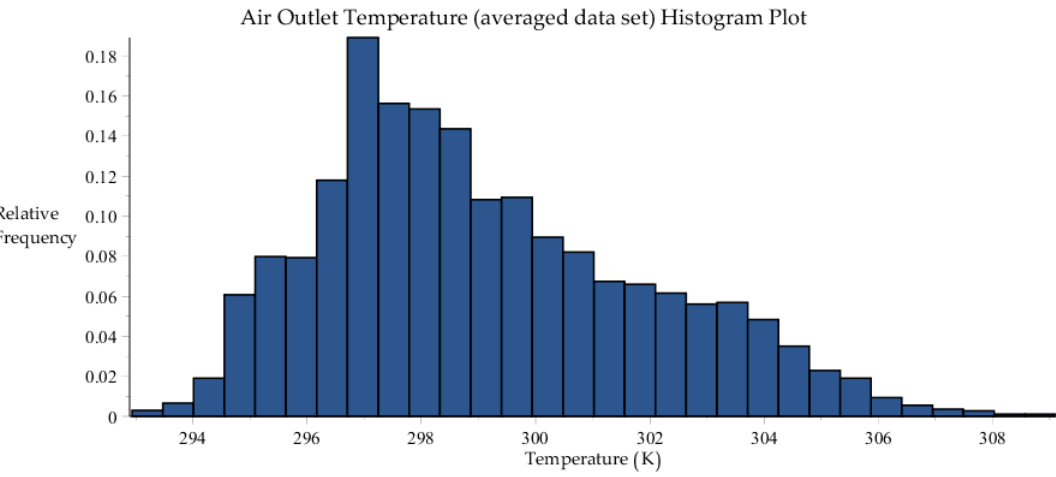
Figure A6. Histogram plot of air outlet temperatures averaged from Figures A3 and A4. Table A2. Statistics of the air outlet temperature distribution [K], measured using “Tidbit” sensors.